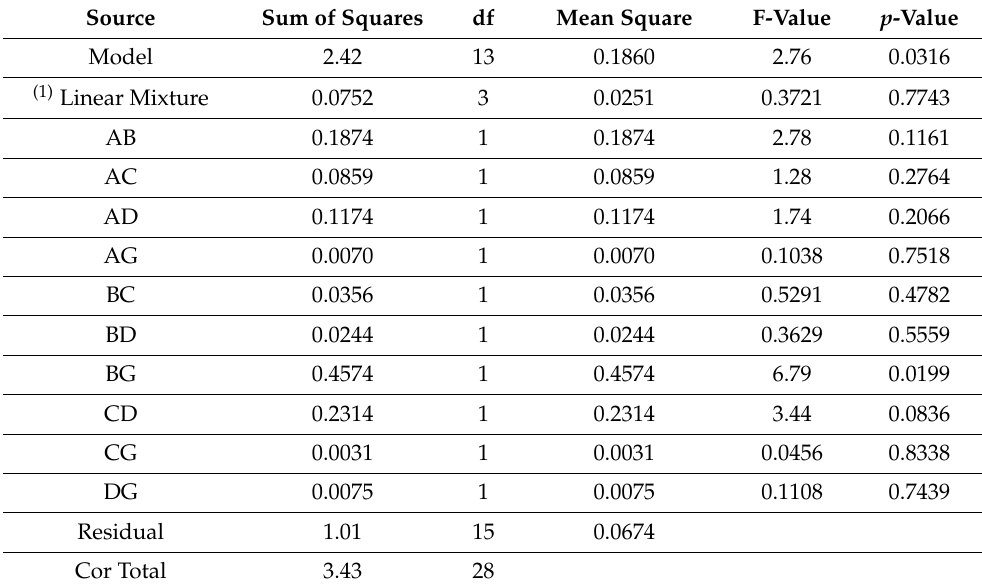
Table 4. ANOVA for reduced quadratic × linear modeling of dry mycelium response. Source Sum of Squares df Mean Square F-Value p -Value Model 2.42